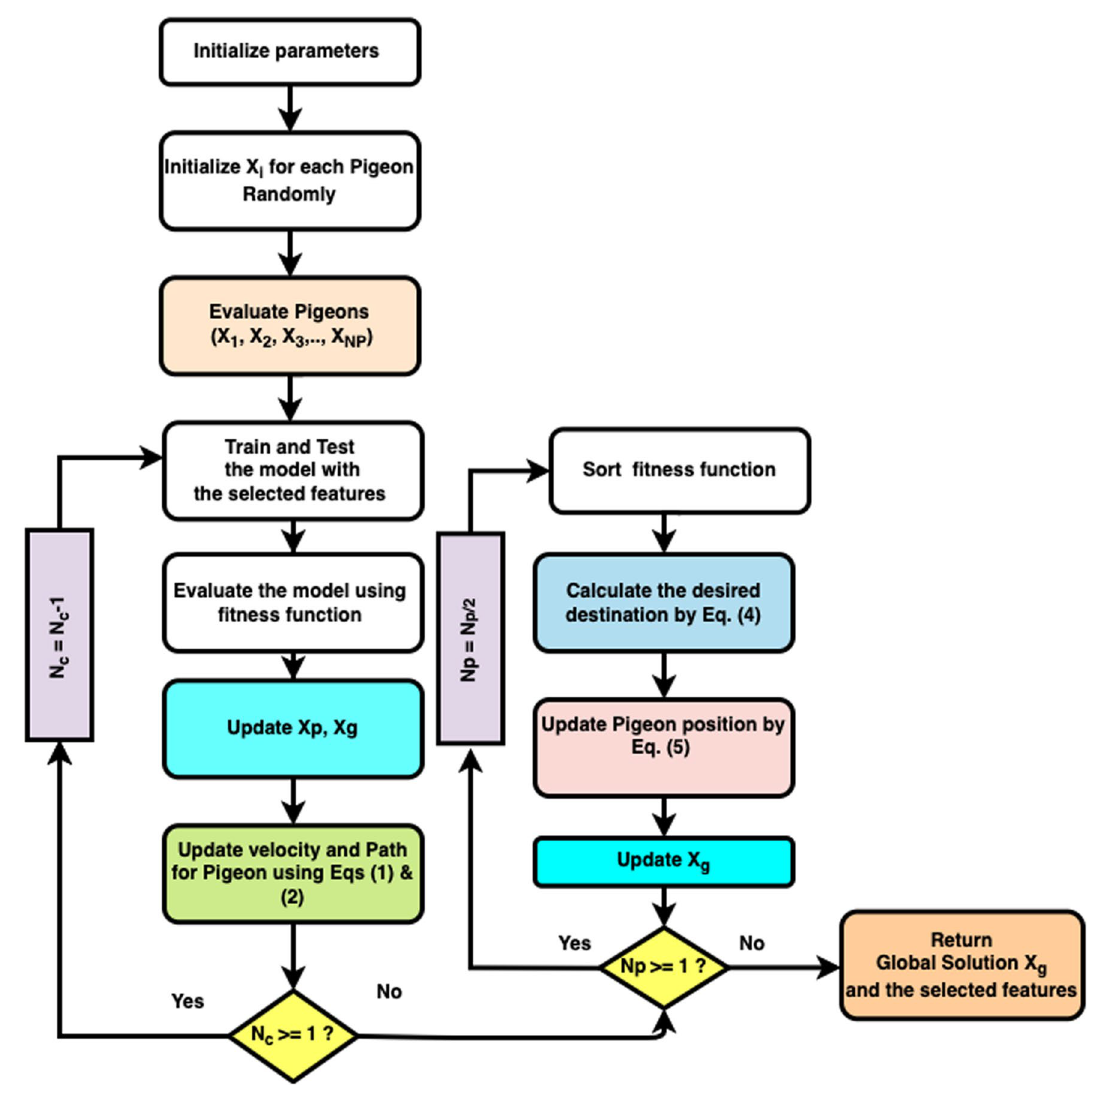
Fig. 1 The flowchart of the PIO